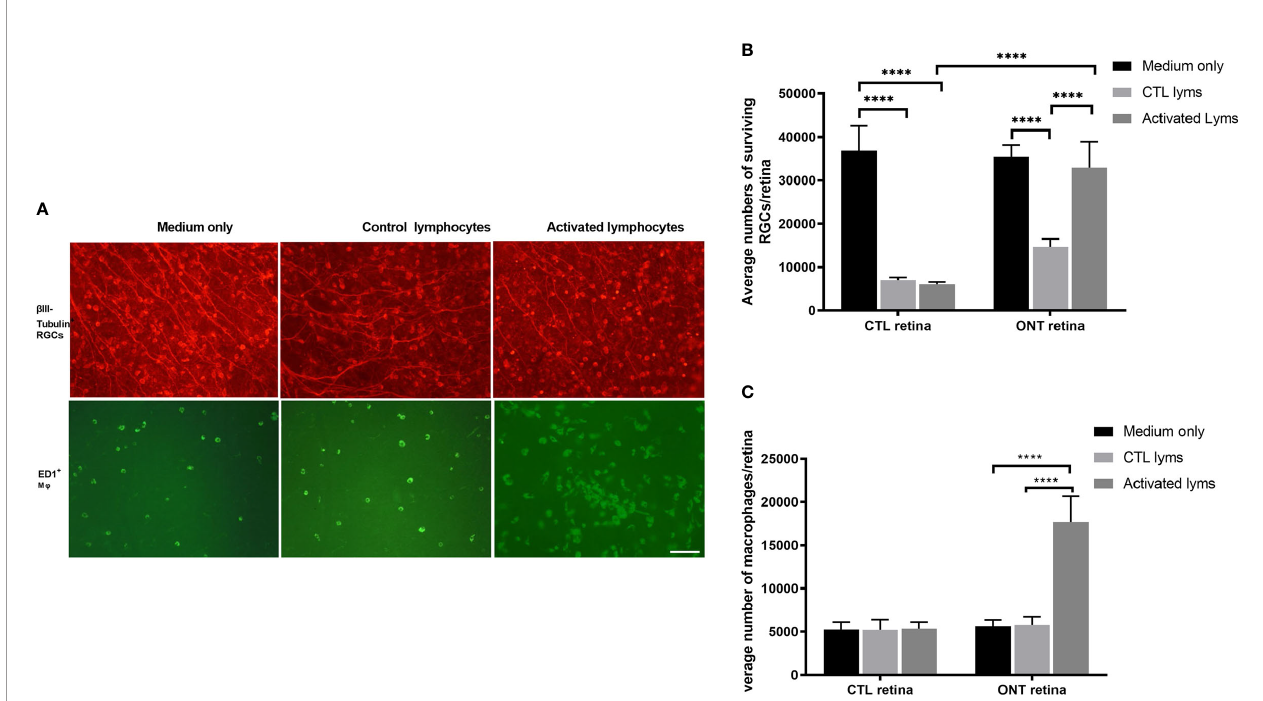
FIGURE 2 | Effect of lymphocyte co-culture on retinal ganglion cell (RGC) survival and macrophage in fi ltration. (A) Representative images of fl at-mounted retinas showing b -III tubulin-positive RGCs and ED1-positive microglia/macrophages. Scale bar, 50 µm. (B) Quanti fi cation of RGCs showed that the co-culture of activated lymphocytes increased the RGCs compared to control lymphocytes co-culture. (C) Quanti fi cation of microglia/macrophages showed dramatic augmentation in the co-culture of activated lymphocytes compared to other culture conditions. Data are presented as means ± SEM (n=4-6 of each group). **** P < 0.0001. The number of retinas in each group was